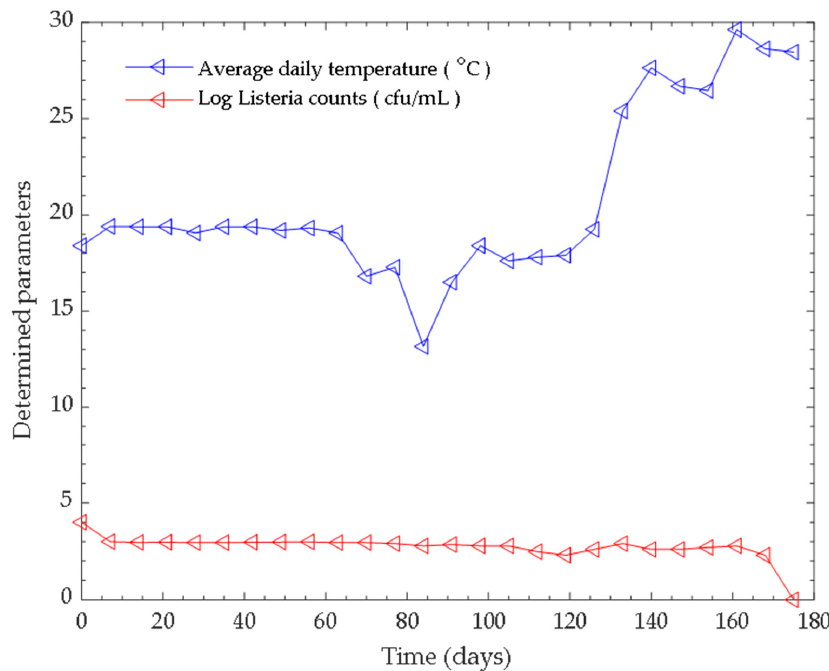
Figure 2. Log bacterial counts and average daily temperature over time.